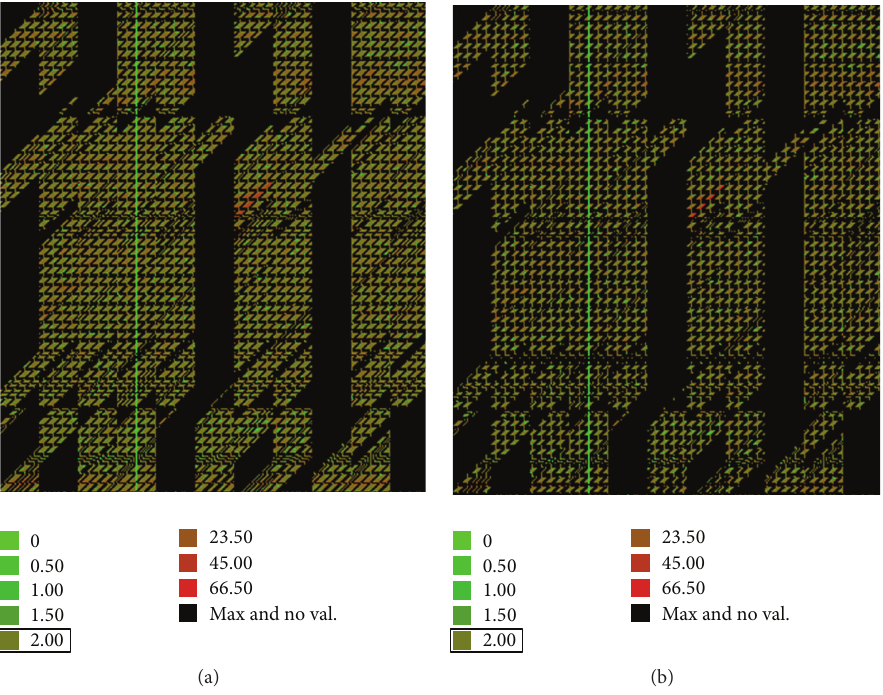
Figure 7: Bitmap of the thermal distances as a result of different filter clustering. (a) f1 and (b)